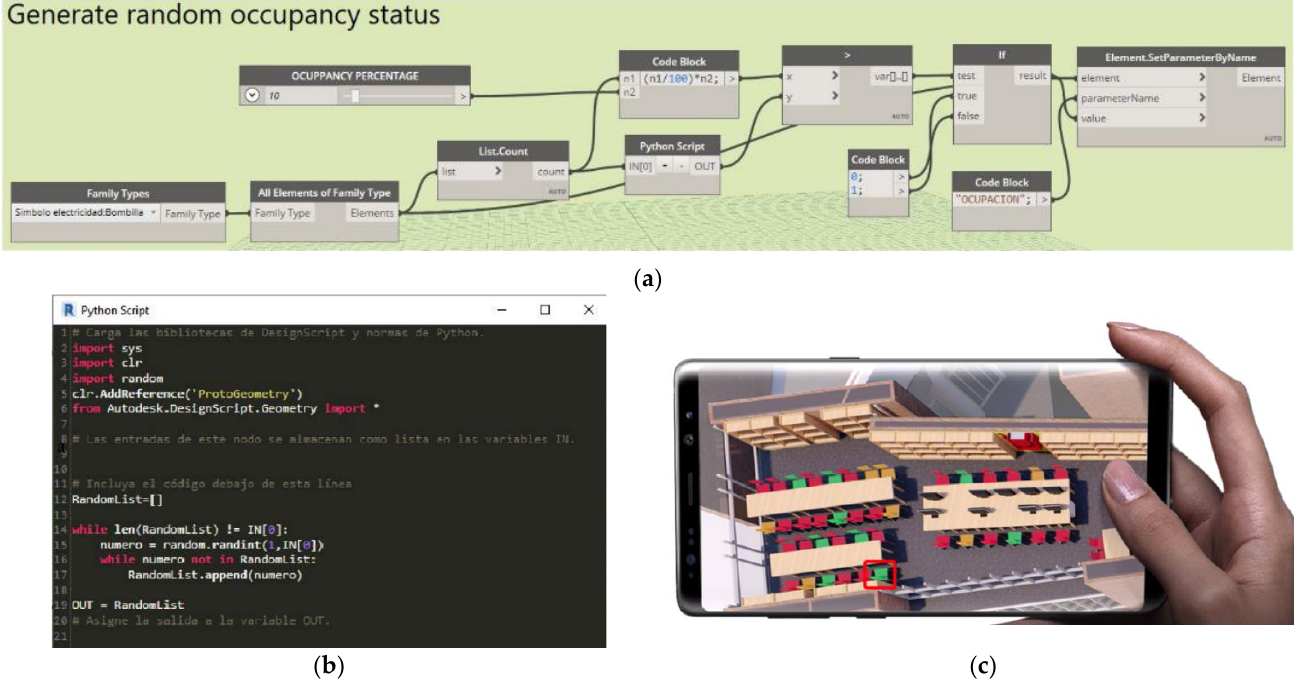
Figure 3. Example of a visual programming definition in which custom algorithms are created ( a ) using Dynamo and ( b ) with the help of Python scripts, which automates ( c ) the graphic display of changes in the occupancy status of seats by applying filters of color, thus providing said information as parameters to the Revit model and rendering them able to be displayed in the app interface.